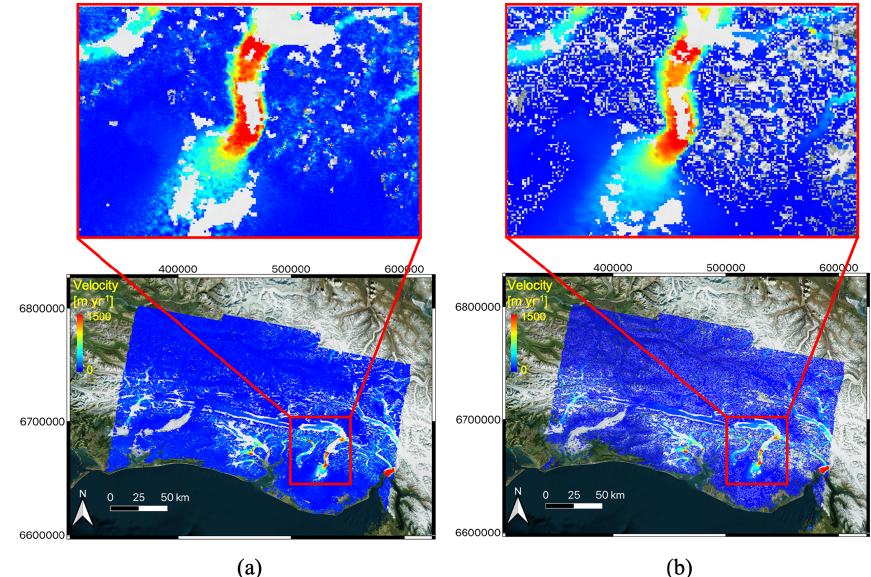
Figure 20. Comparison of the (a) ITS_LIVE Sentinel-1 image-pair product to the (b) FAU product over the test site at the Malaspina Glacier in Alaska. Both datasets are generated using Sentinel-1 images acquired on 20190225 and 20190303. Background: © Microsoft Bing Maps 2022.